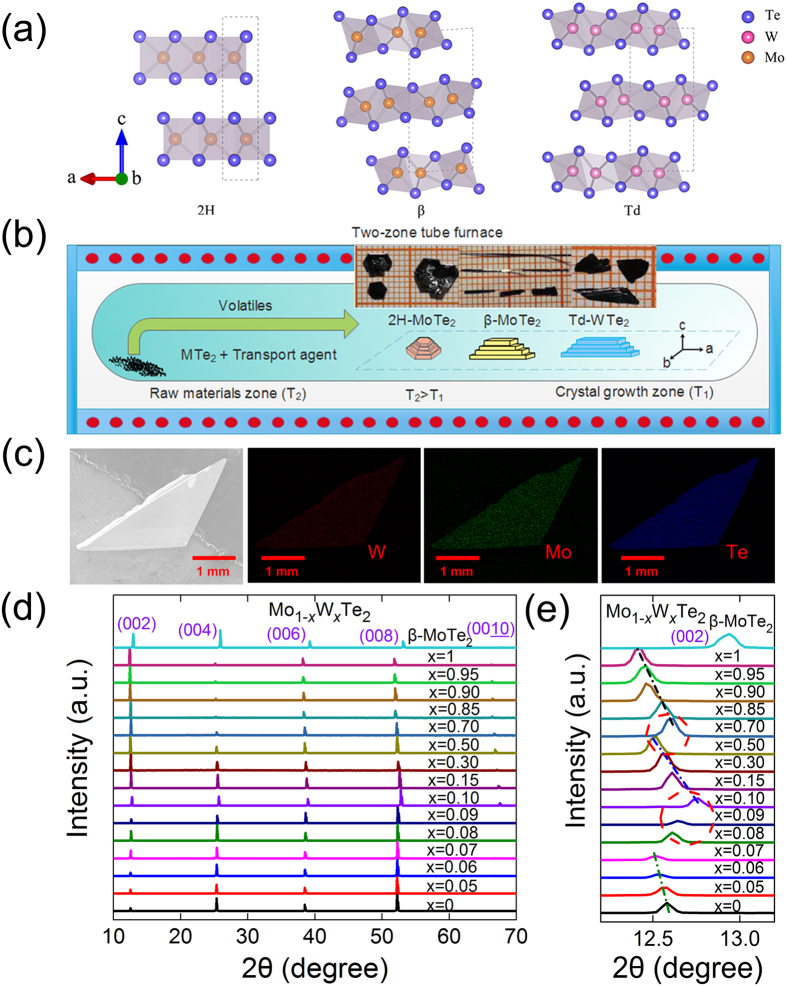
(a) Crystal structure of Mo/WTe2 (2H, β and Td phase, respectively). (b) Schematic of the double-zone CVT growth furnace and the growth process of Mo1−xWxTe2 single crystals. (c) SEM image and W (red), Mo (green) and Te (blue) element mapping images of Mo0.5W0.5Te2 single crystal. (d) The XRD patterns of representative Mo1−xWxTe2 single crystals. (e) The enlarged (002) XRD peaks for all samples.